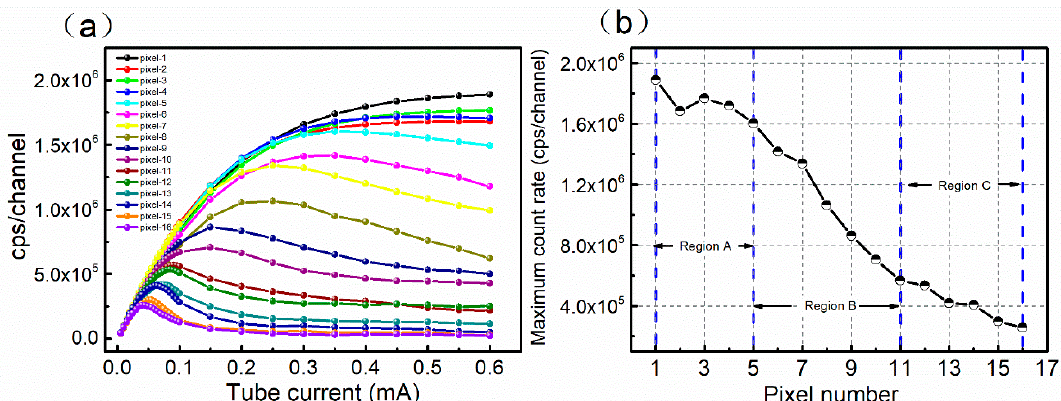
Figure 2. ( a ) Count rate performance of the 16-pixel CdZnTe photon counting detector; ( b ) trend of the maximum count rate of the 16 pixels. The regions A, B and C represent the high counting performance region, the medium counting performance region and the poor counting performance region.